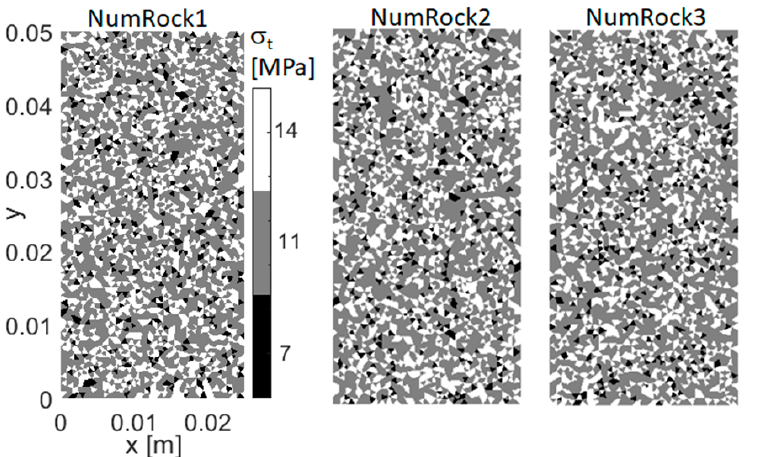
Figure 3. Tensile strength distribution in numerical rock samples (quartz = white, feldspar = gray, biotite =